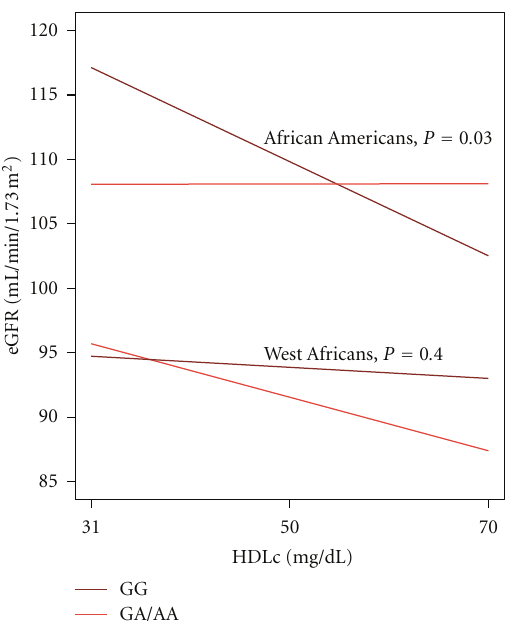
Figure 3: Association between HDLc and eGFR among African Americans and West Africans by rs73885319 Genotype . The modification of the association between HDLc and eGFR by rs73885319 genotype (GG = nephropathy risk genotype), as esti- mated from a linear mixed model of HDLc × rs73885319, adjusting for HDLc rs73885319, age, age 2 , sex, and overall proportion of admixture (African Americans only), with random clustering for family. Among those with the nephropathy risk genotype, the association was much more negative than among those without this genotype ( β : − 0.38 versus 0.001, P interaction = 0 .